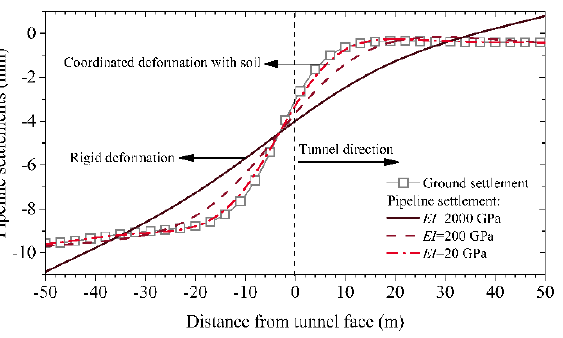
Figure 16. Longitudinal profiles of pipeline’s deformation with different equivalent bending stiff- ness.